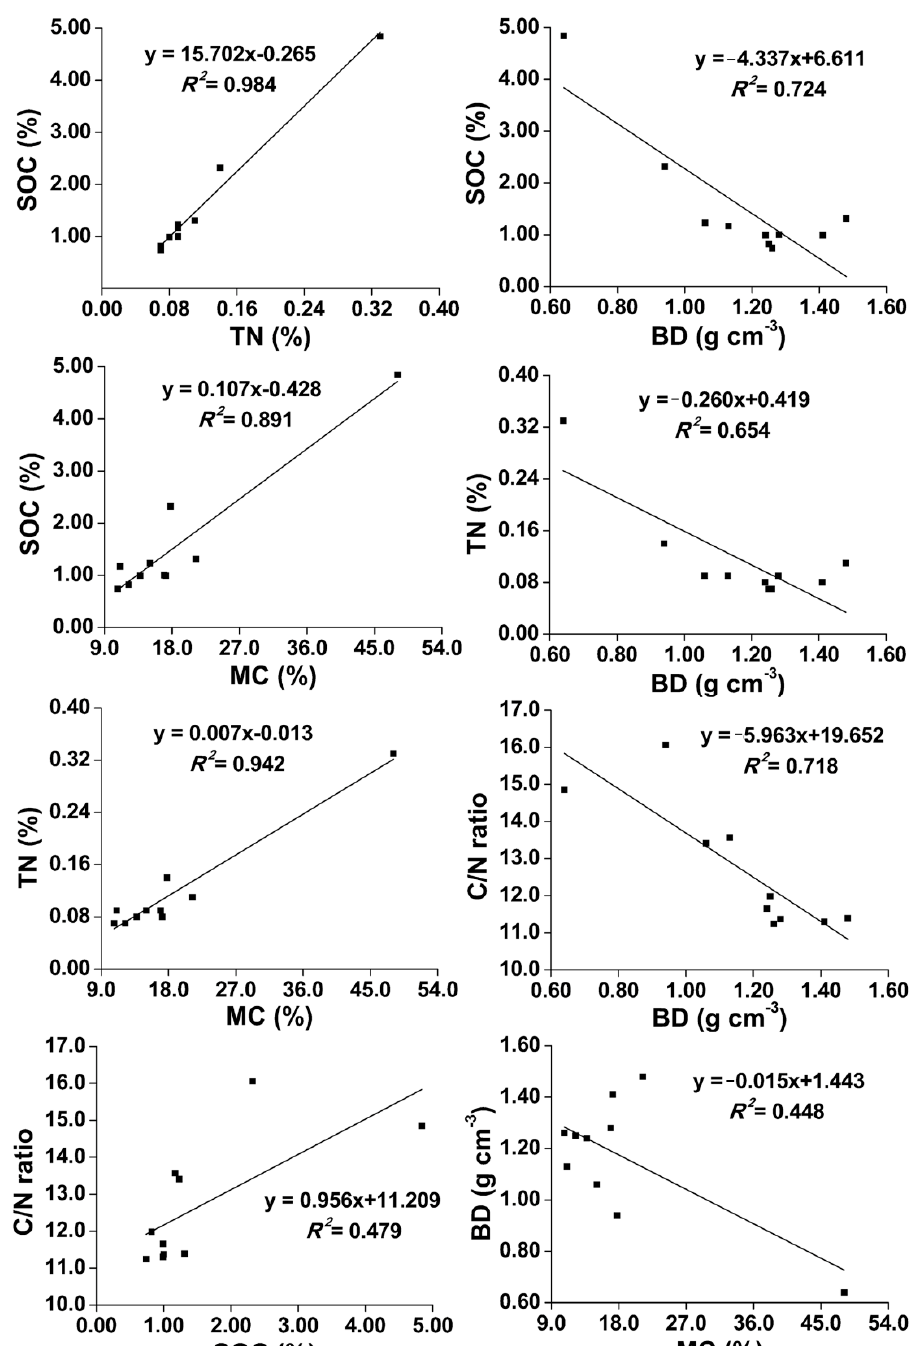
Figure 4. Relationships between soil properties of two island forest wetlands.